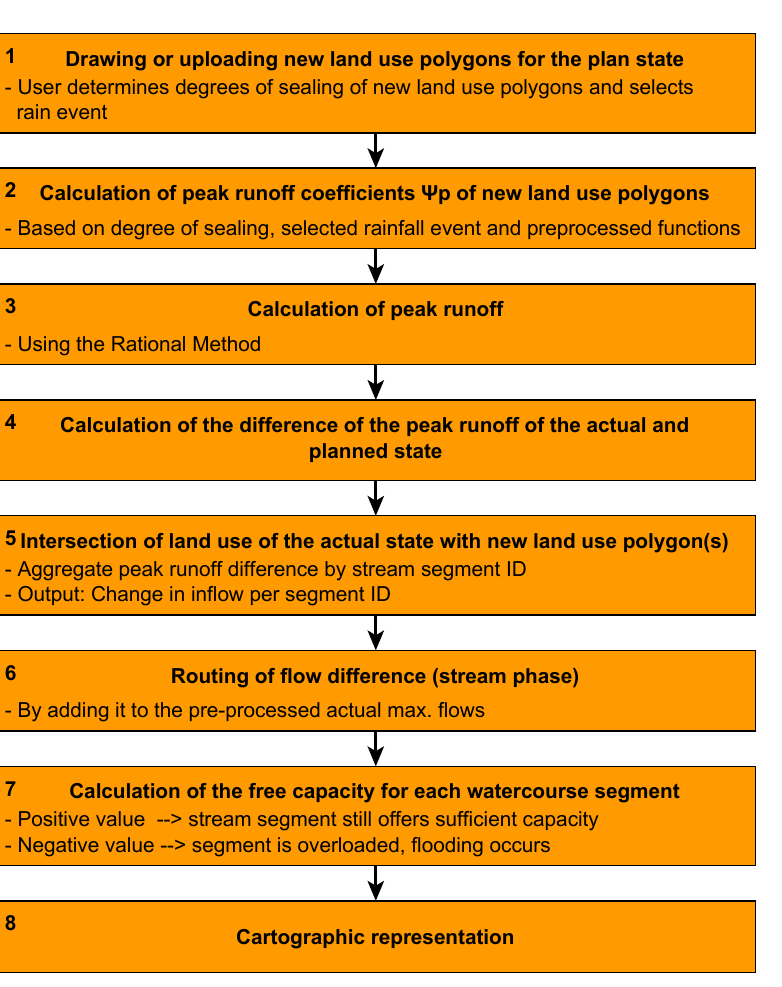
Figure 3. Determination of flood characteristics for the planned state of land use using GIS-DSS tools.